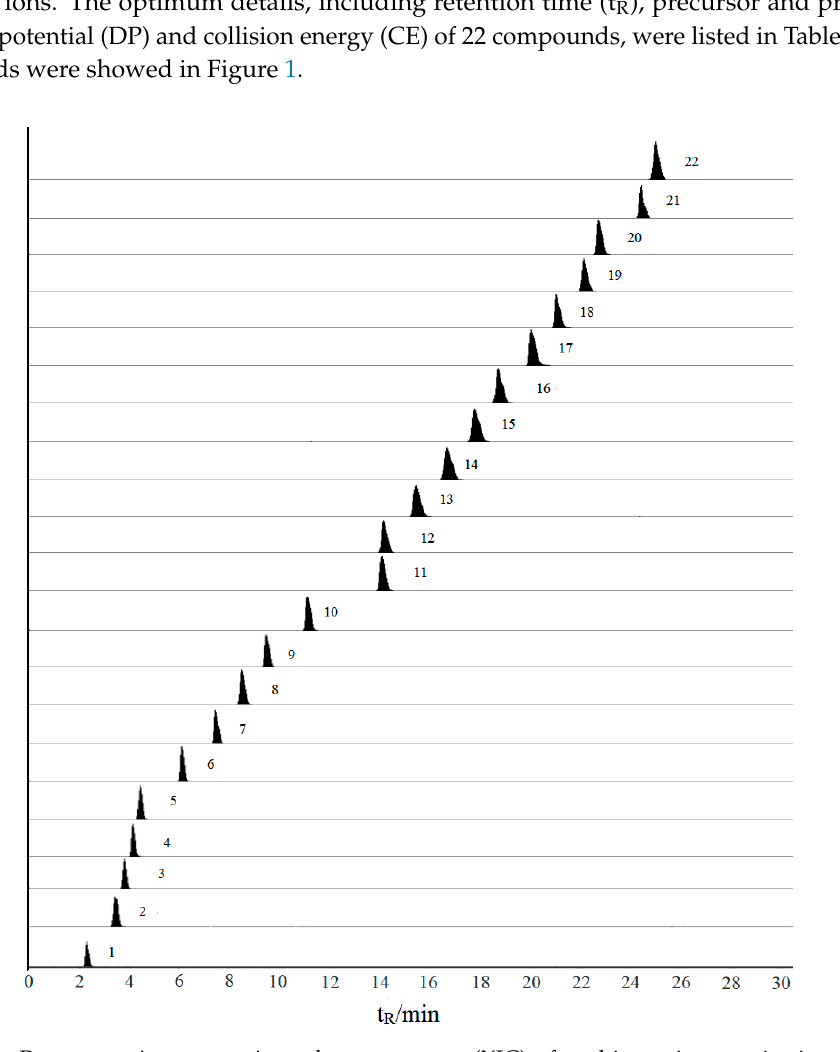
Figure 1. Representative extract ions chromatograms (XIC) of multi-reaction monitoring (MRM) chromatograms of 22 investigated compounds. (Compounds were shown in Table 1).